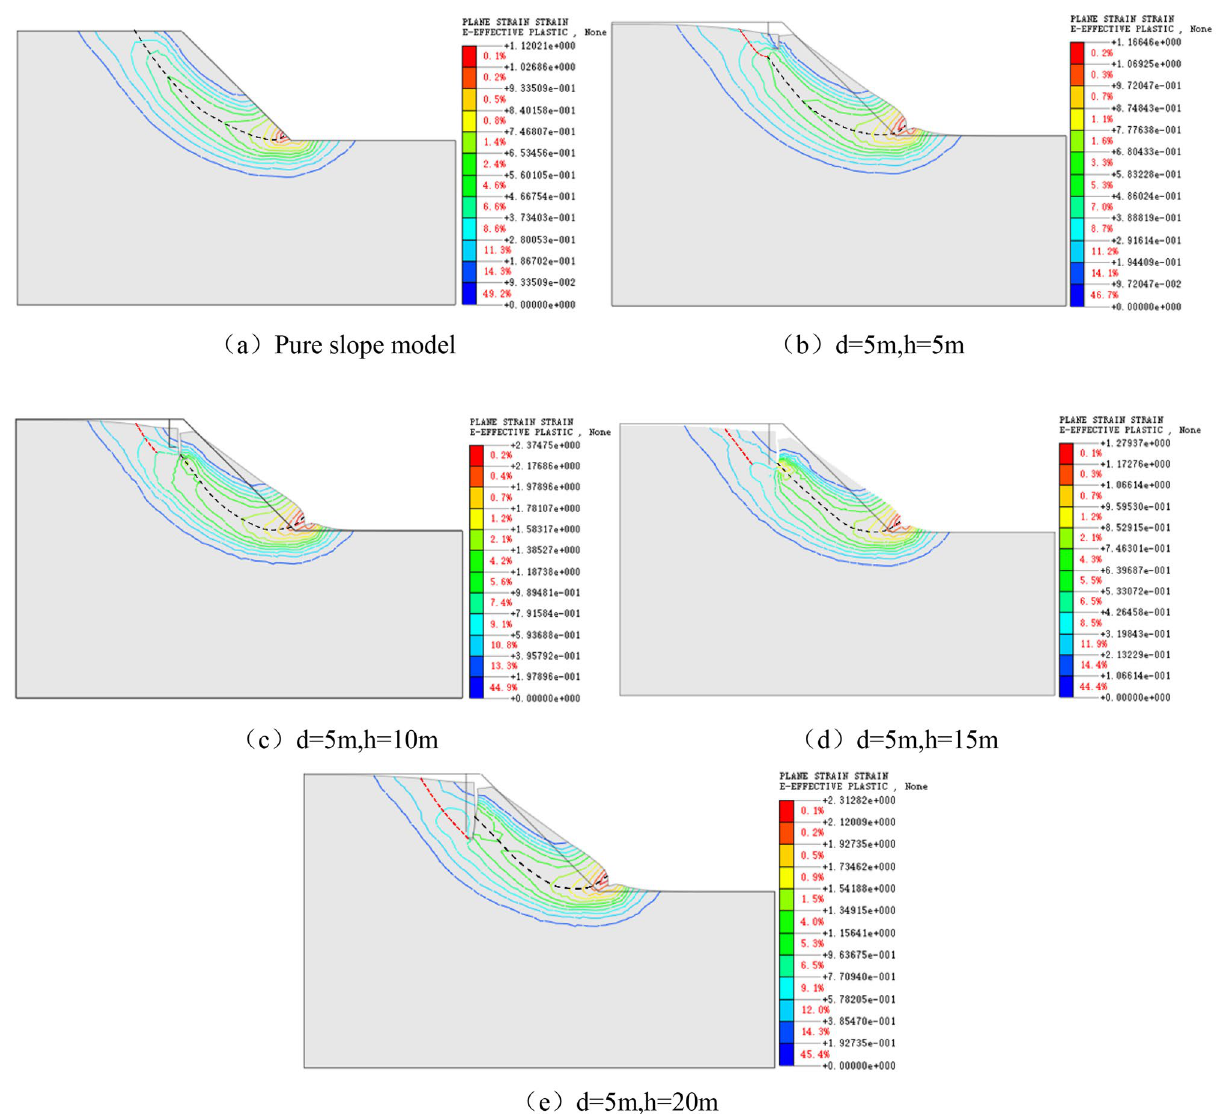
Figure 6. Cloud chart of the plastic zone and sliding surface with vertical joints d = 5 m and h = 5–20